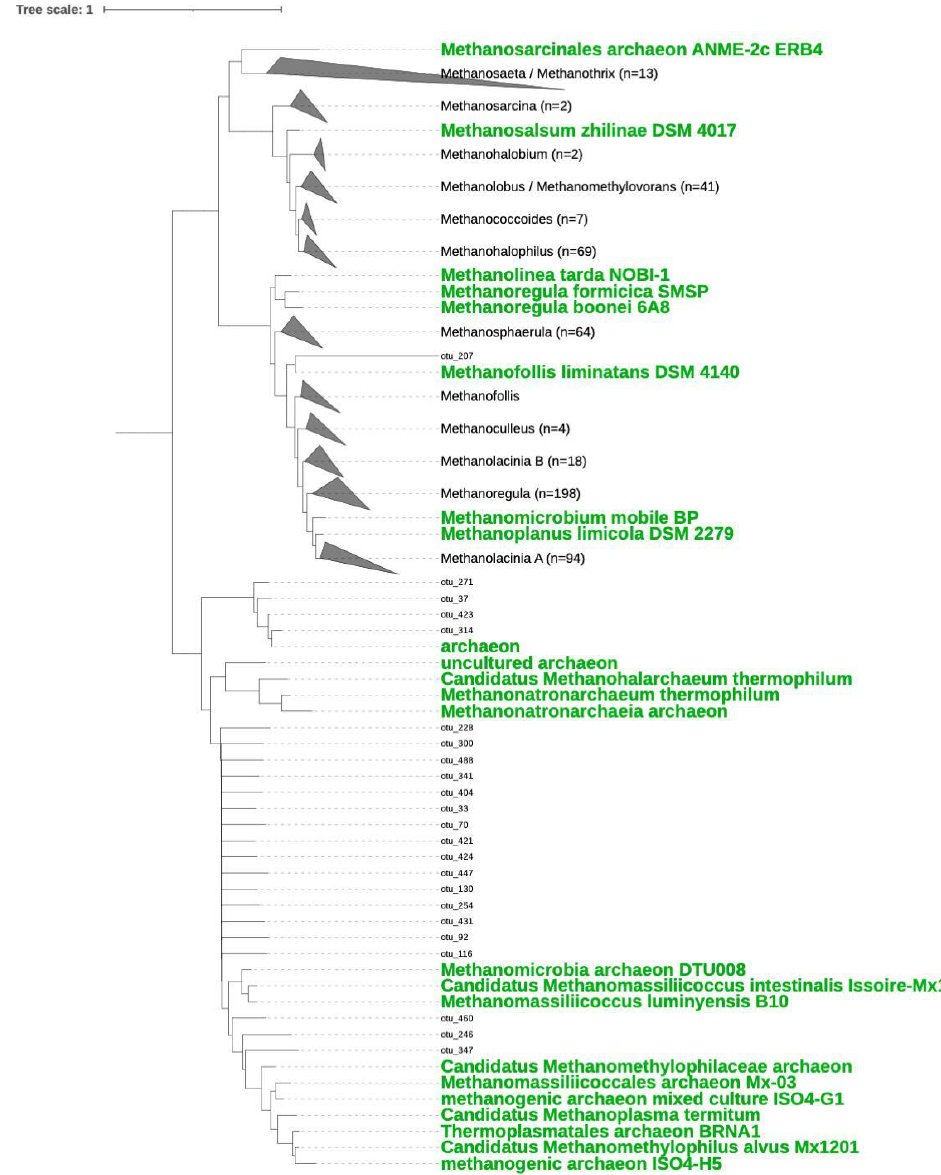
Figure 3. Phylogenetic tree of representative OTUs representative of McrA amino acid sequences in relation to a reference tree. Collapsed groups are represented with triangles, and the clade is labelled after the closest reference. The numbers of OTUs in the collapsed branches are shown in brackets. Terminal nodes corresponding to referenced sequences are labelled in green.